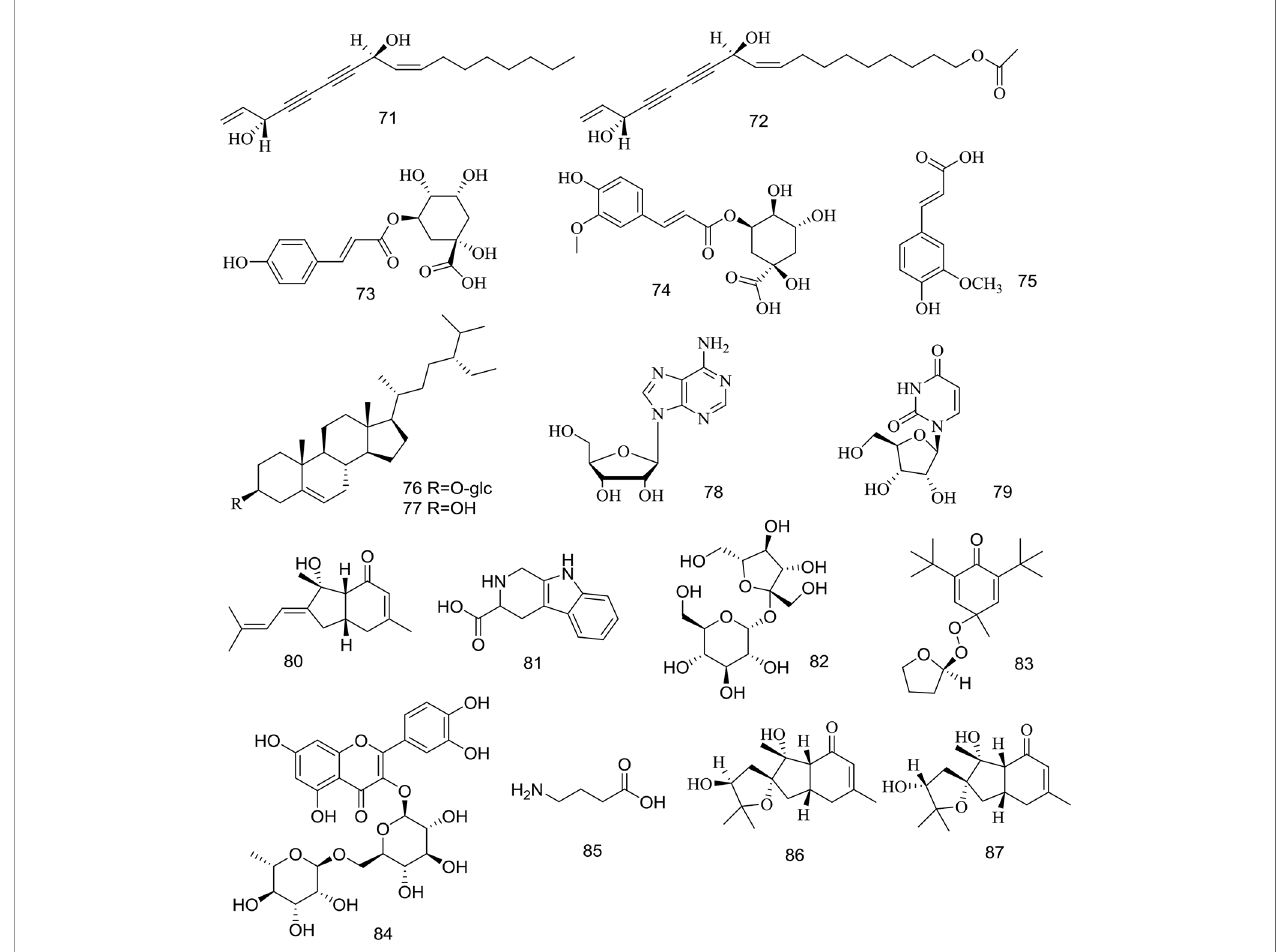
FIGURE 3 | Structures of polyene-alkynes (71, 72) , phenolic acids (73 – 75) , steroids (76 – 77) and others (78 – 87) isolated from medicinal plants as